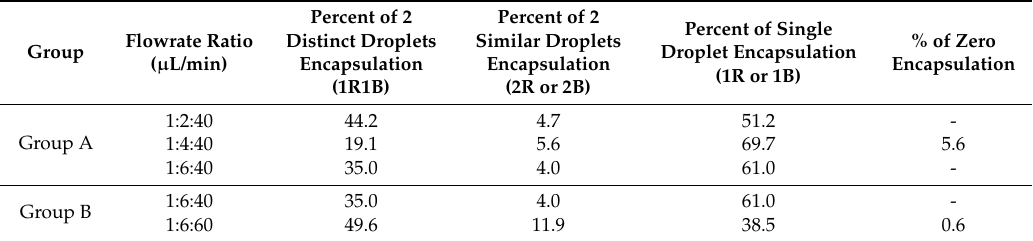
Table 5. Success rate of the encapsulation for each